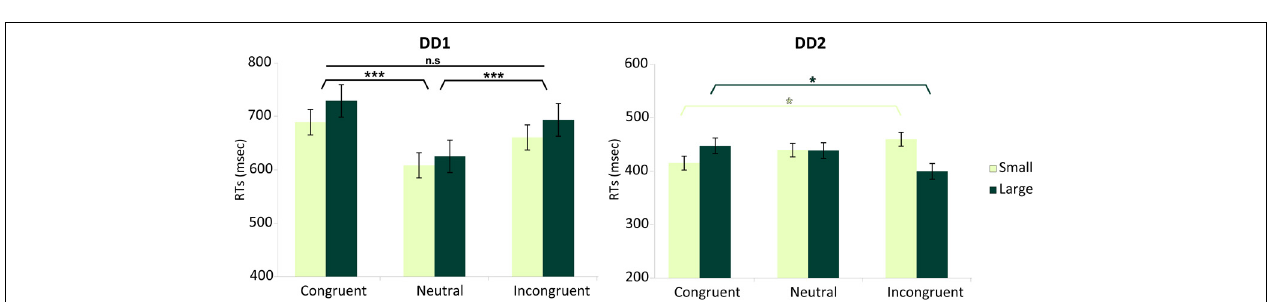
pattern typical of the Congruency effect (Incongruent > Congruent) was only present for small distances (e.g., 2–4) ( p < 0 . 05); while the reverse pattern (Congruent > Incongruent) characterized DD2’s performance with large numerical distances (e.g., 2–7) ( p < 0 . 05). Main effects are shown in black (DD1’s profile). Interaction is shown in shades of green (DD2’s profile). Data are mean ± standard error (SE) of the mean. ∗ p < 0 . 05; ∗∗∗ p < 0 .